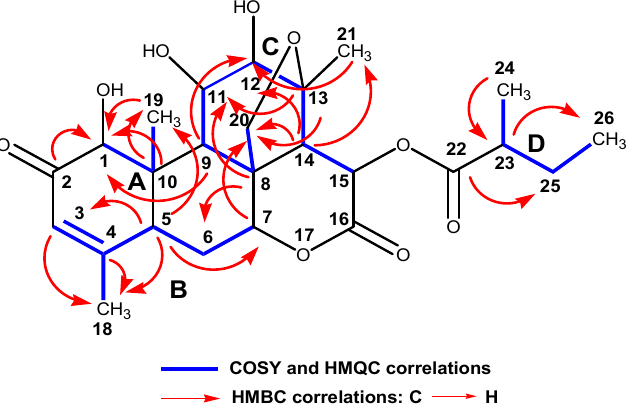
Figure 2. HPLC chromatogram of Fraction 3 (SH2C3) containing simalikalactone D (SKD). SH2C3 fraction was purified on a C18 column with a mixture of methanol and water (55:45, v/v) as a mobile phase, at flow rate of 0.65 mL/min and with UV detection at 220 nm. SKD was collected separately in the interval of 15.57 min.